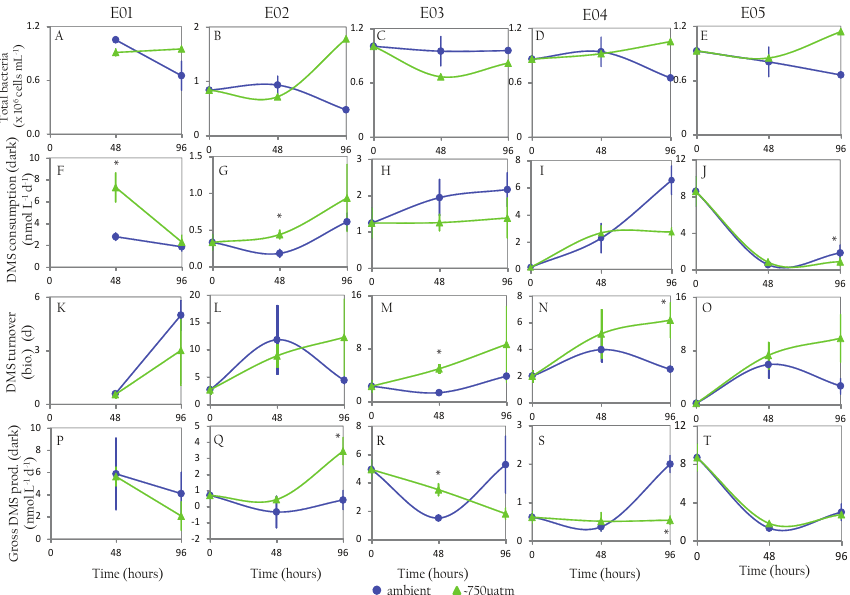
Figure 5. DMS consumption rates (nmolL − 1 d − 1 ) (a–e) , biological DMS turnover (d) (f–j) , DMS gross production rates (k–o) and total bacteria counts (cellsmL − 1 ) (p–t) during five bioassay experiments at ambient p CO 2 and ∼ 750µatm. DMS turnover times (d) = 1/loss rate constant ( k BC , d − 1 ) . Data are summarised in Table S6 in the Supplement. Error bars indicate standard error on triplicate rate measurements. Asterisks (*) denote significant difference from ambient CO 2 bioassays (significance of F ratio from ANOVA, p <0.05). No measurements were made at 0h for E01. Smoothed lines on plots do not represent extrapolation of data between time point measurements but are used to highlight